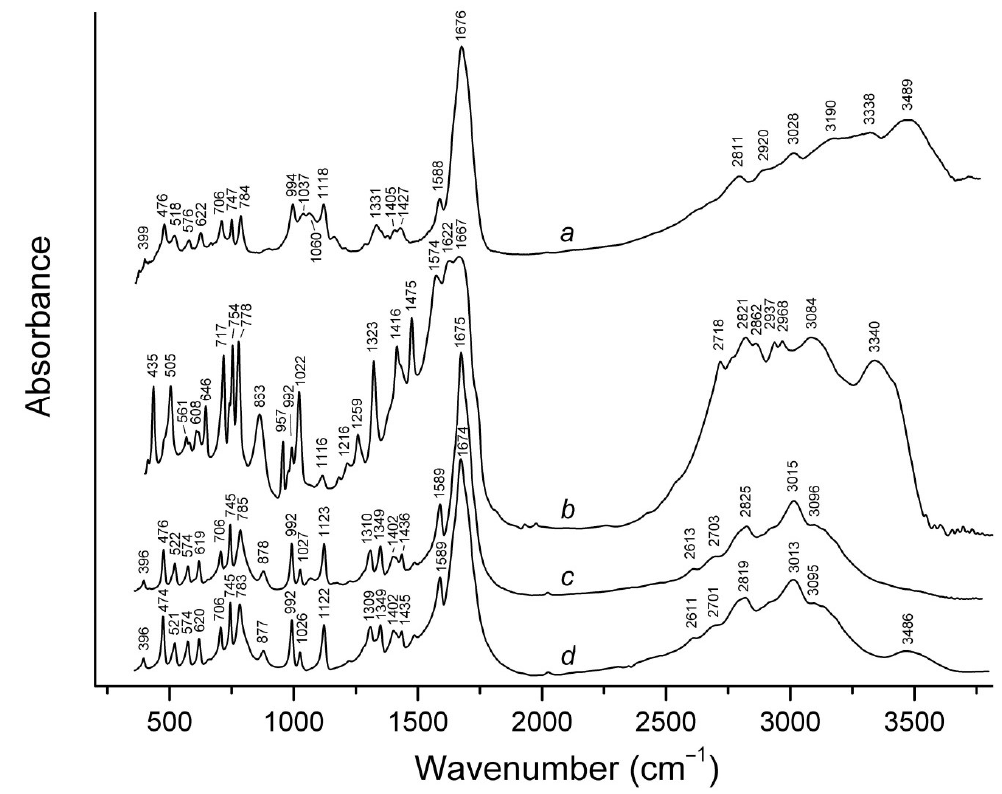
Figure 8. IR spectra of a: UAD, b: uric acid monohydrate [20], c: UA, and d: a product of incomplete UAD (holotype tinnunculite) dehydration in dry air at room temperature.